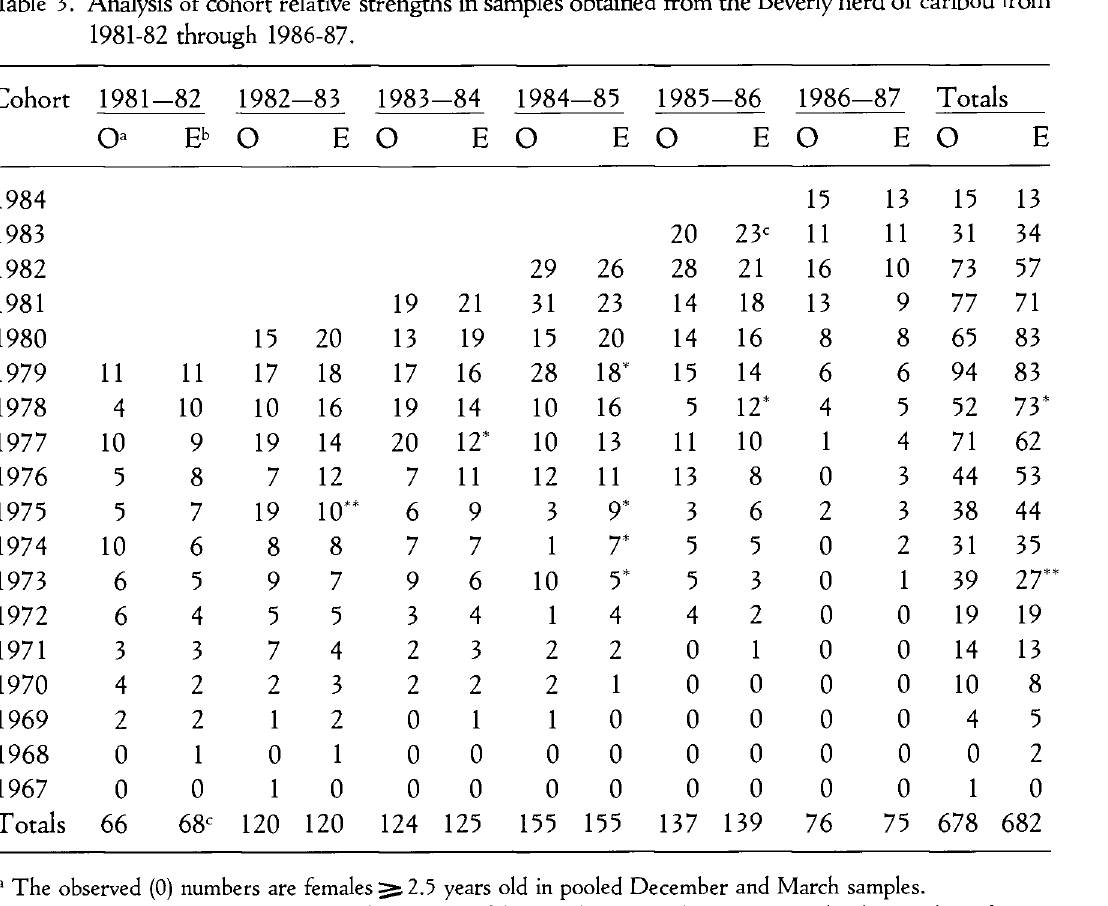
Table 3. Analysis of cohort relative strengths in samples obtained from the Beverly herd of caribou from 1981-82 through